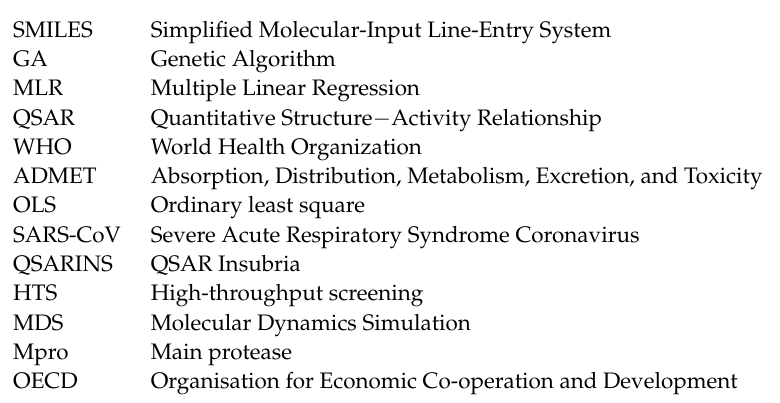
used in the model. Table S2: Details regarding performance of model. Table S3: Correlation matrix for validation of QSAR models and the formulae for the statistical parameters. Table S4: SMILES screening. Figure S1: Different graphs associated with model (a) graph of experimental vs. residual values (b) Y-scrambling